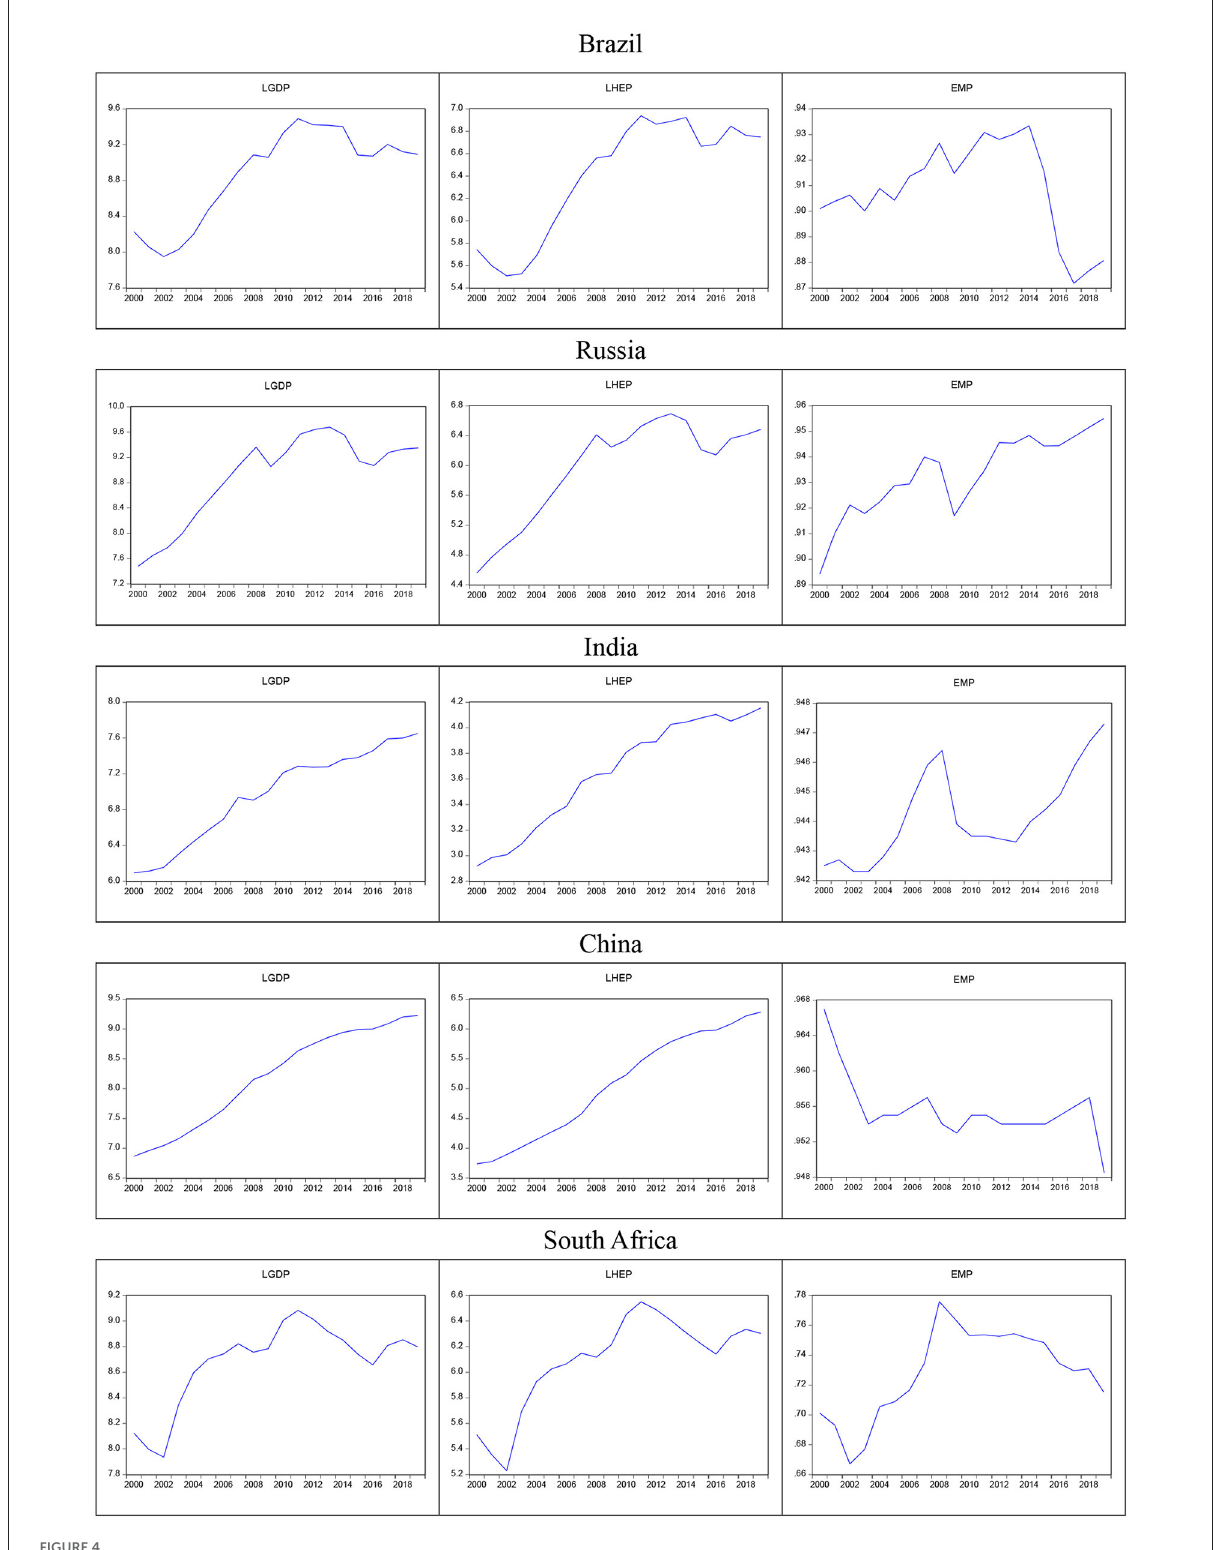
FIGURE4 BRICS 2000-2019 GDP, health expenditure and employment